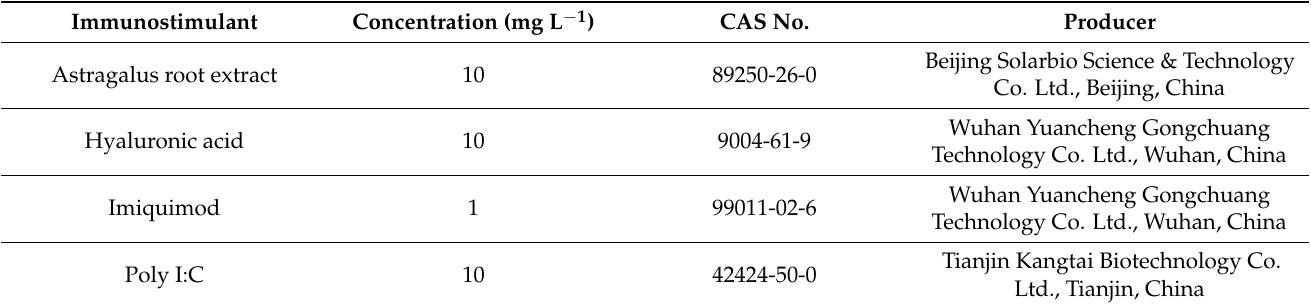
Table 1. Immunostimulants used in the present study, including concentration used, CAS number, and producer. Immunostimulant Concentration (mg L − 1 ) CAS No. Producer Astragalus root extract